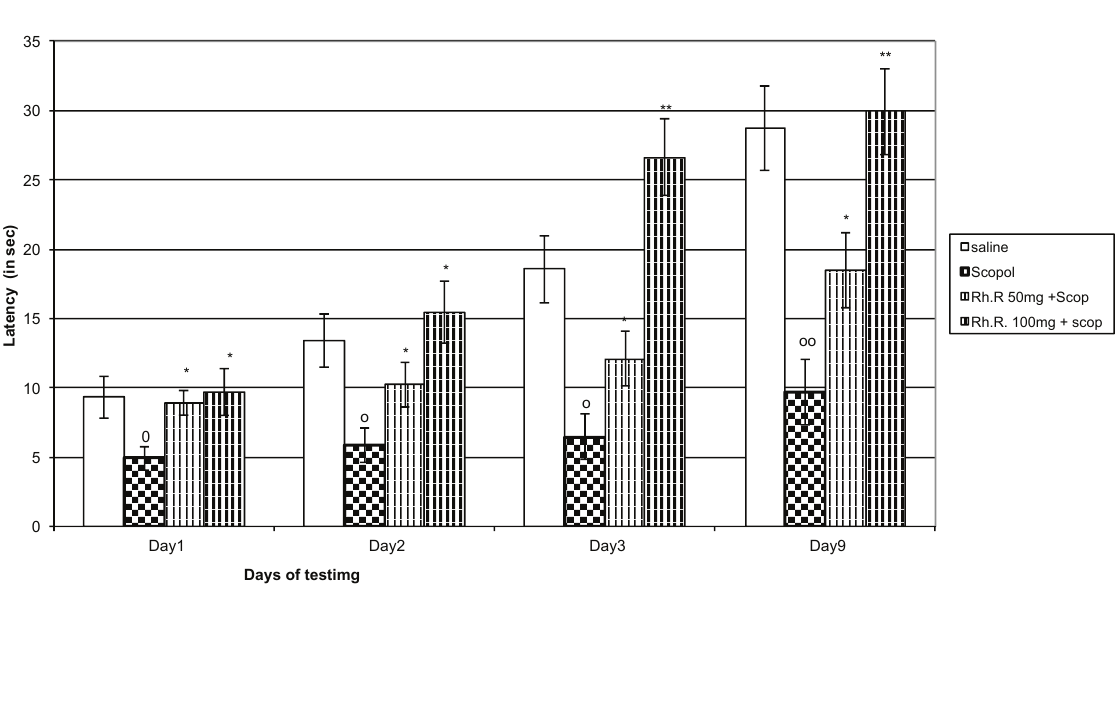
Figure 3. Effects of Rhodiola rosea extract on step-down test in rats with scopolamine-impaired memory. Abscissa: 2-day learning session, short and long memory retrieval. Ordinate: the latency of reaction in seconds. o P<0.05 compared with the fi rst day control; * P<0.05 compared with same day scopolamine group.